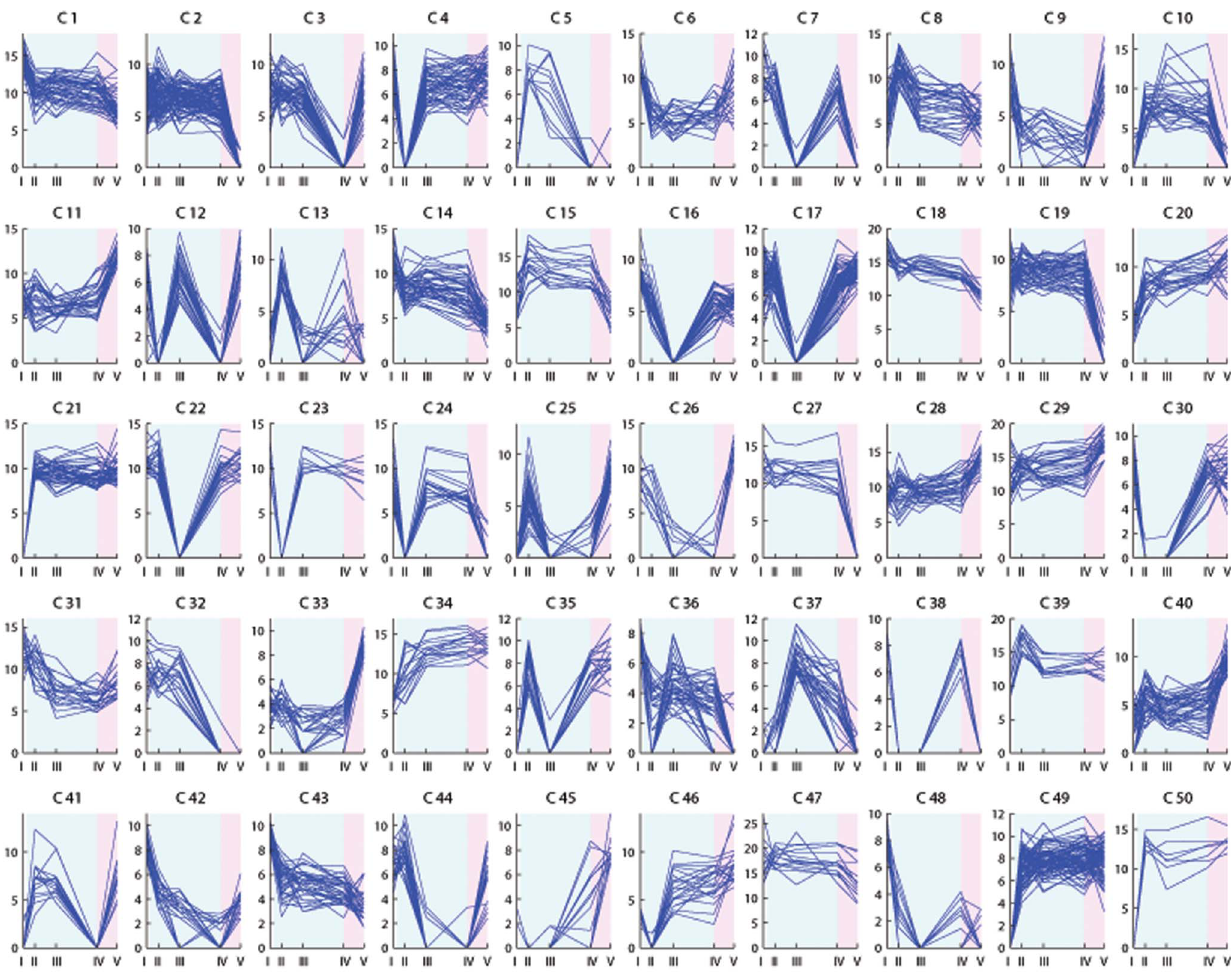
Figure 4. K-means clustering analysis of transcripts differentially expressed in Veyo leaf samples. K=50 clusters. The x axis presents the sample collection time points: I= autumn conditions, before the start of vernalization; II=2 days of vernalization; III=4 weeks of vernalization; IV=9 weeks of vernalization; V=7 days of long day conditions. The y axis corresponds to the variance stabilized data from DESeq. The blue background illustrates vernalization treatment, the pink background illustrates long day